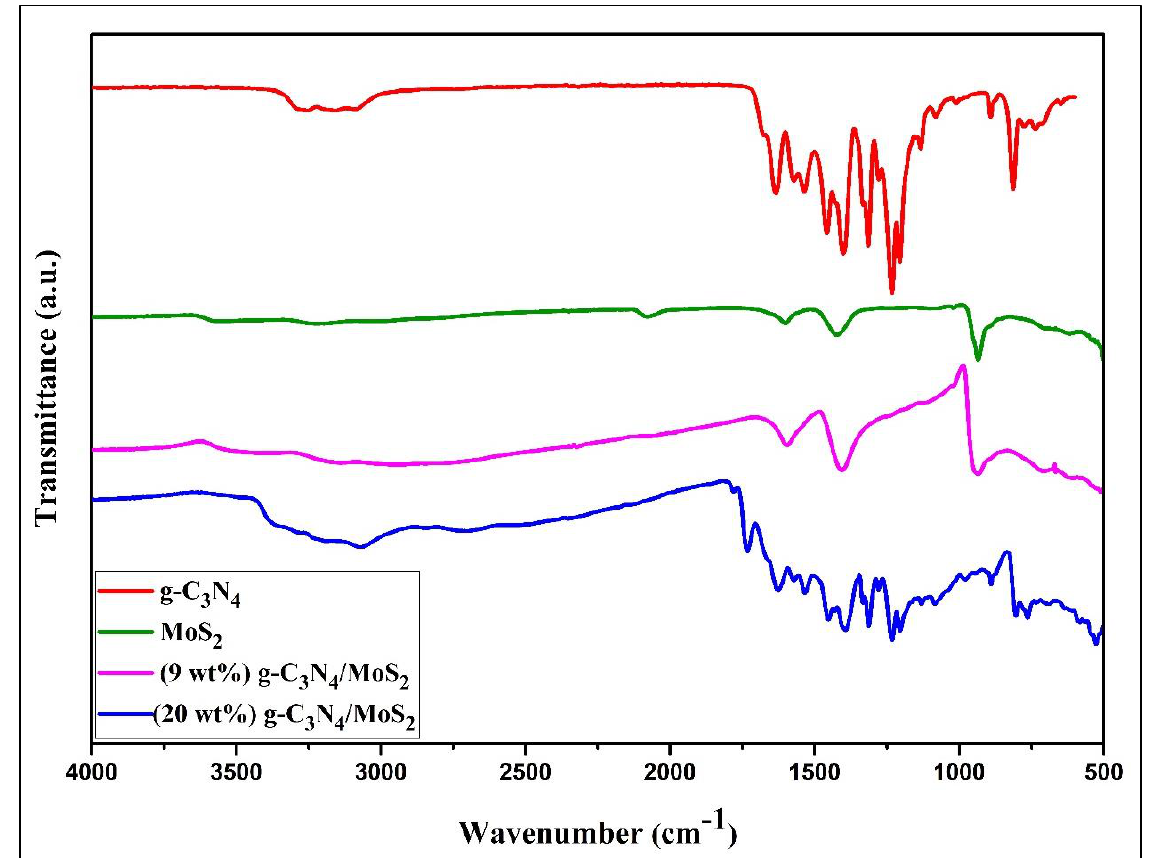
Figure 5. FTIR pattern of MoS 2 , g-C 3 N 4 and their composites.